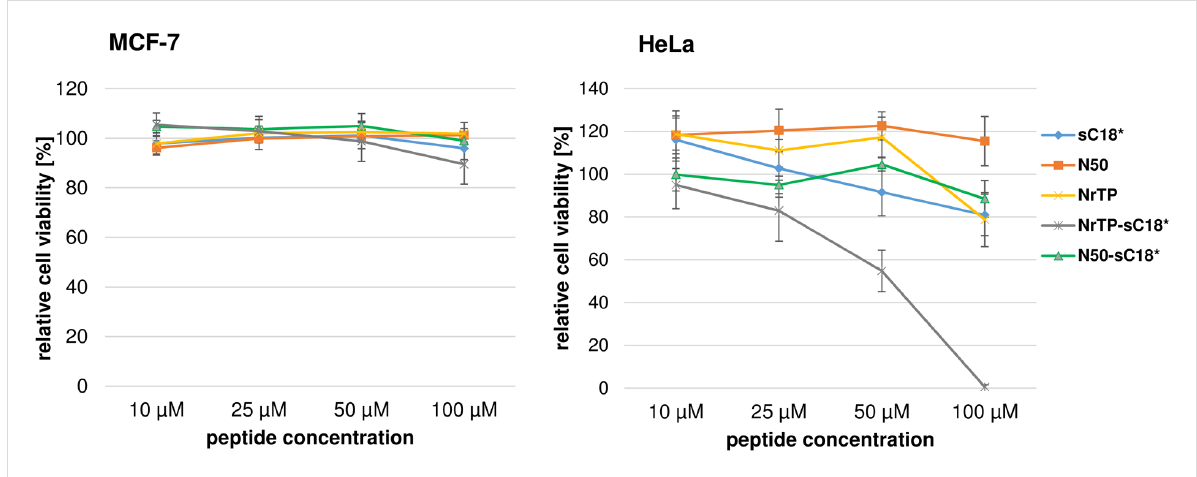
Figure 2: Cytotoxicity profiles of the peptides in MCF-7 and HeLa cells. Cells were incubated for 24 h with different concentrations of peptide solu- tions. Untreated cells served as negative control, cells treated with 70% ethanol as positive control. Values from the positive control were subtracted from all data, and the untreated cells were set to 100%; assays were performed with n = 3 in triplicate.